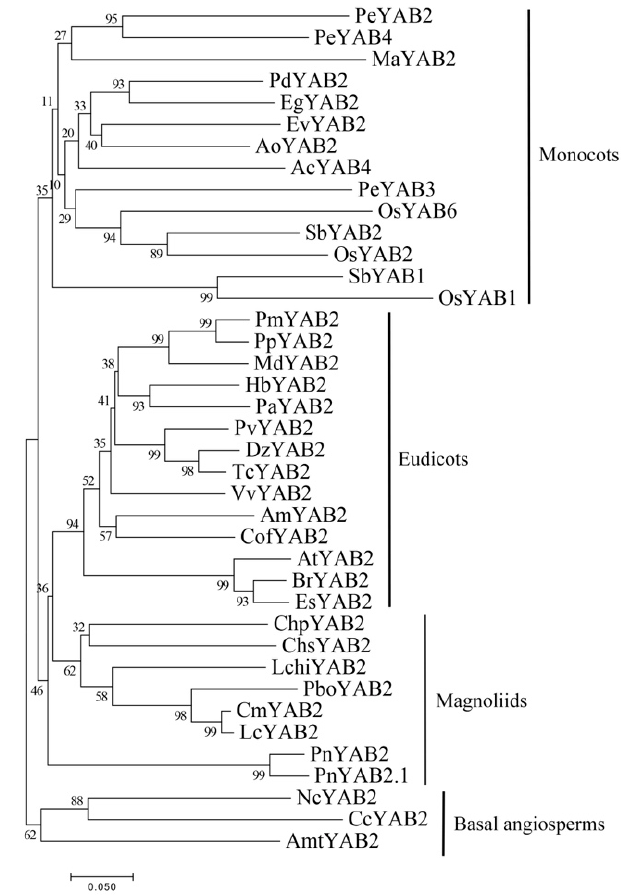
Figure 6. Phylogenetic tree of YAB2 proteins from various angiosperms. The phylogenetic tree was constructed with the NJ method using MEGA 7.0 software. Bootstrap analysis was conducted with 1000 replications. The same acronym represents the same species: Cm: C. micranthum ; Chp: C. praecox ; Lc: L. cubeba ; Chs: C. salicifolius; Pbo: P. bournei ; Pn: P. nigrum ; Lchi: L. chinense . The protein accession list for related proteins is collected in Table S1.